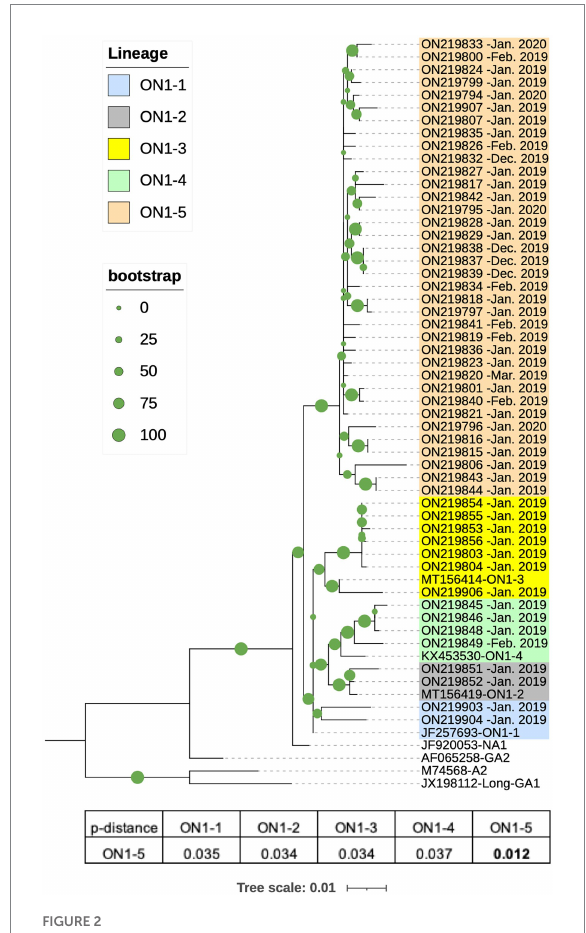
FIGURE 2 Phylogenetic analysis of G gene sequences of RSV-A strains circulating in Shanghai, January 2019–March 2020. RSV-A G sequences obtained from RSV-A-positive samples in this work along with reference strain sequences were used to generate a phylogenetic tree using Randomized Axelerated Maximum Likelihood (RAxML) with 1,000 independent bootstrap searches. Average pairwise distances between ON1-5 strains and other ON1 lineages were calculated using Molecular Evolutionary Genetic Analysis